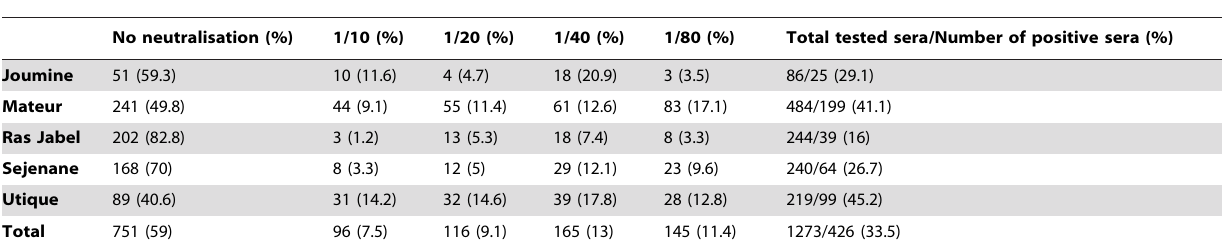
Table 5. Results of seropositivity for TOSV MN, according to serum dilution and geographic origin.